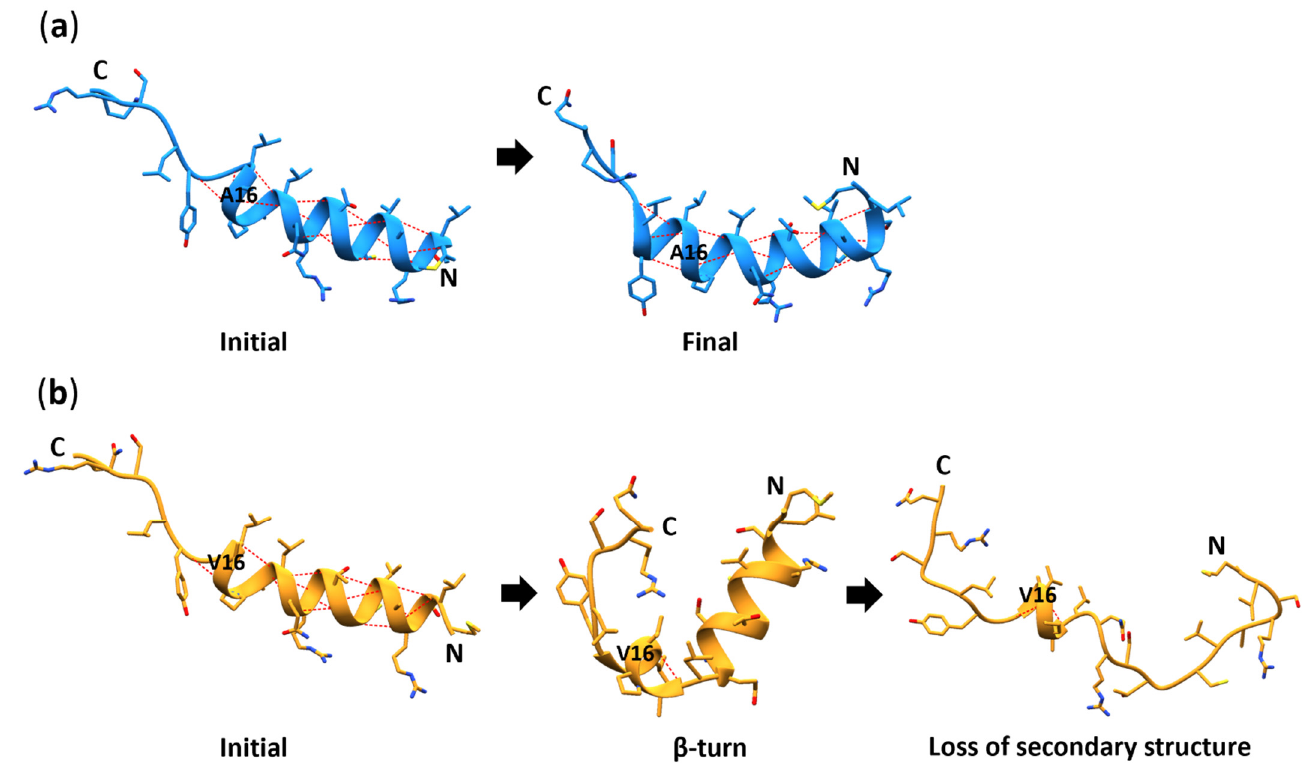
Figure 8. Cartoon and stick (residues 1–24) representations of the MTS during MD simulations. Initial and final structures are depicted for ( a ) the Ala-MTS, and with an additional transitional for ( b ) the Val-MTS. Blue and orange ribbons represent the secondary structure of the Ala- and Val-MTS, respectively. Side chains are depicted with sticks; blue/orange is for carbon, red for oxygen, dark blue for nitrogen, and yellow for sulfur. The red dashed lines denote intramolecular hydrogen bonds.